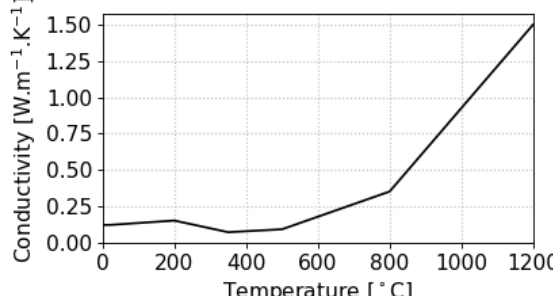
Figure 7. EC5 timber thermal conductivity.